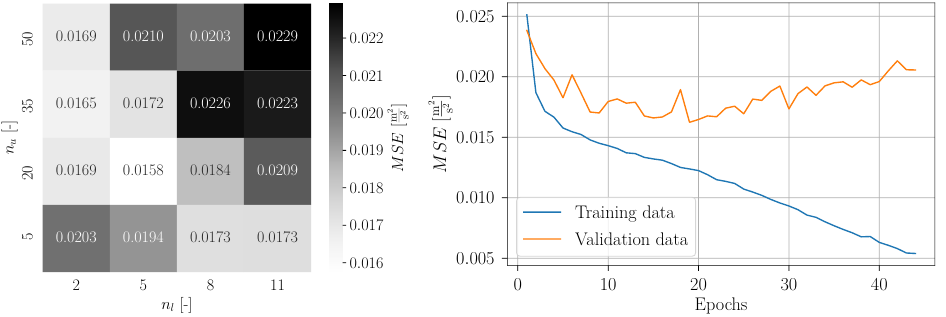
Figure 41. Visualization of the grid search results for adjusted n in and n out ( left ) and the learning curve of a subsequent training for n l = 5 and n u = 20 ( right